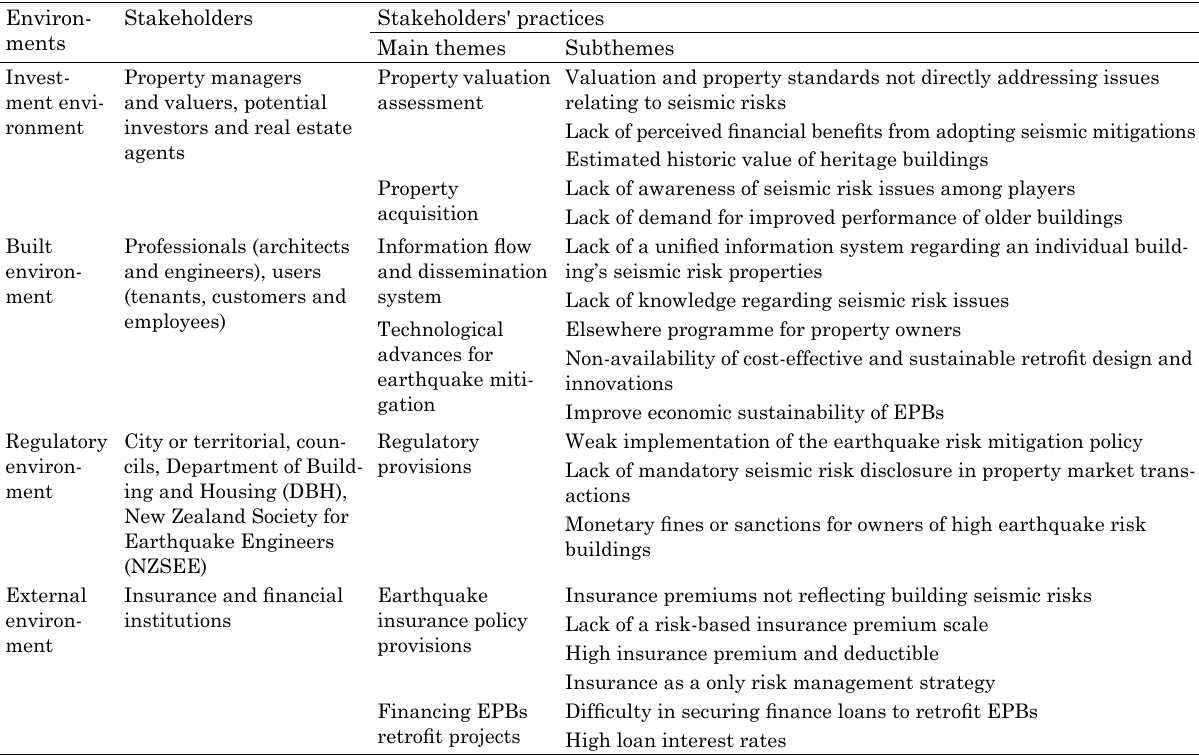
Table 2. Interview findings – stakeholders’ practices affecting earthquake mitigation decisions Environ-